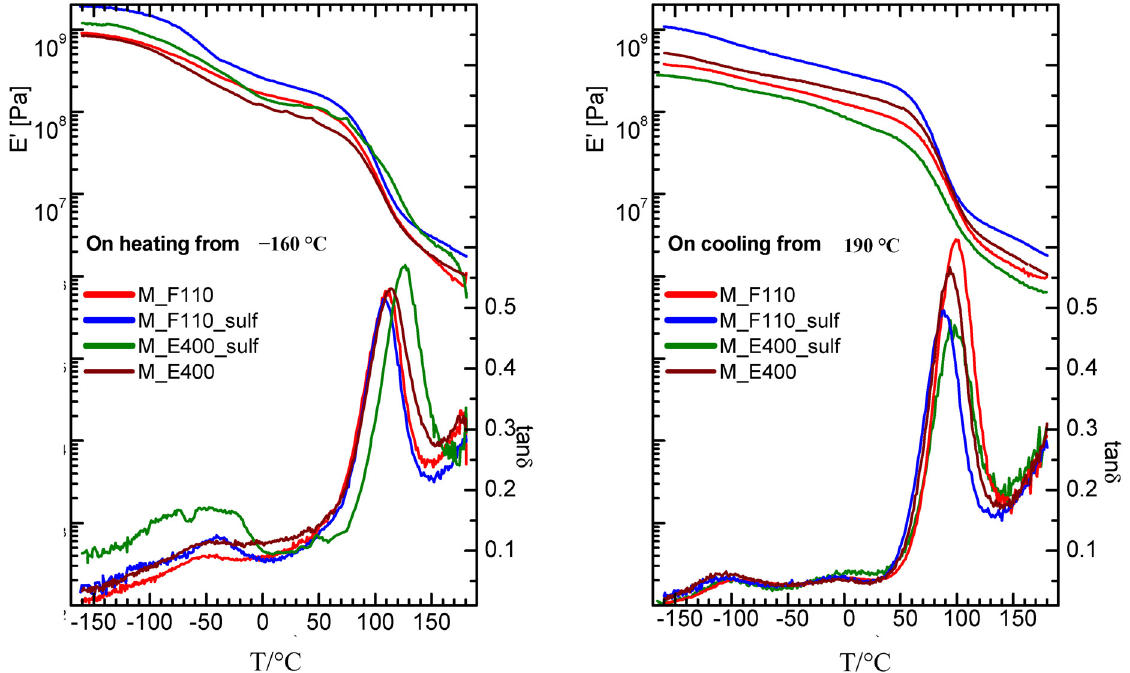
Figure 8. Storage modulus and elastic energy dissipation of nanocomposite membranes measured for f = 1 Hz on heating (left panel) and subsequent cooling (right